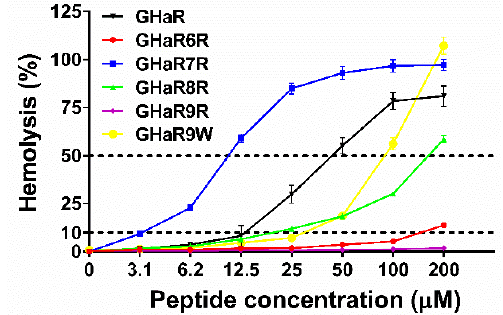
Figure 2. The hemolytic toxicity of GHaR and the derived peptides. The dashed line represented 10% and 50% hemolysis.